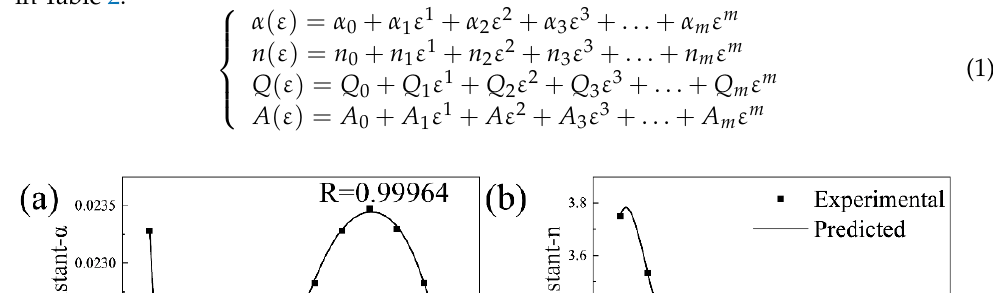
Table 2. Coefficients of the polynomial for material constants α , n , Q , and A .